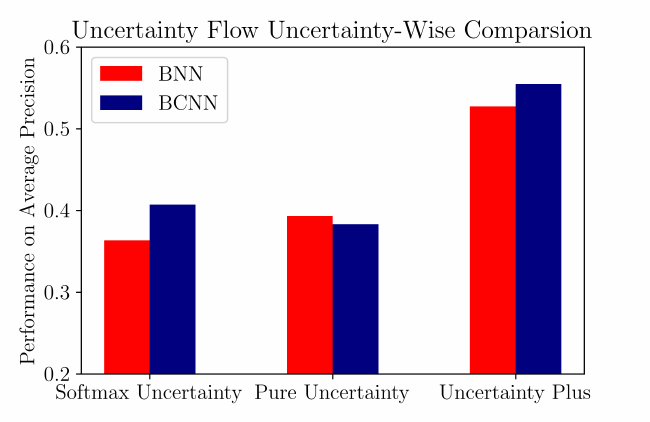
Figure 8. Discriminative Performance Across Different Prediction Related Uncertainty Indexes. Note here, the effects of priors were marginalised via prior-wise